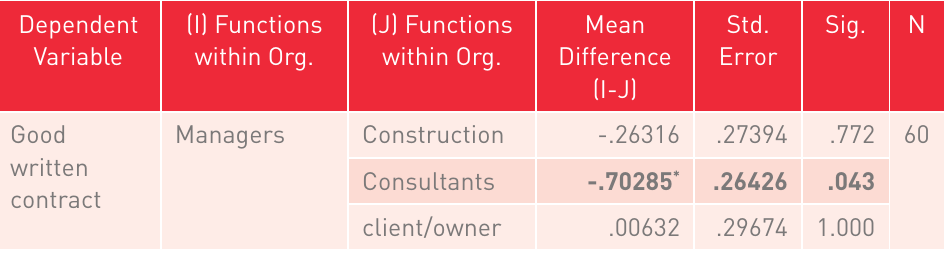
Turkey HSD Table of Post-hoc Tests on the CSFs for managing PDR